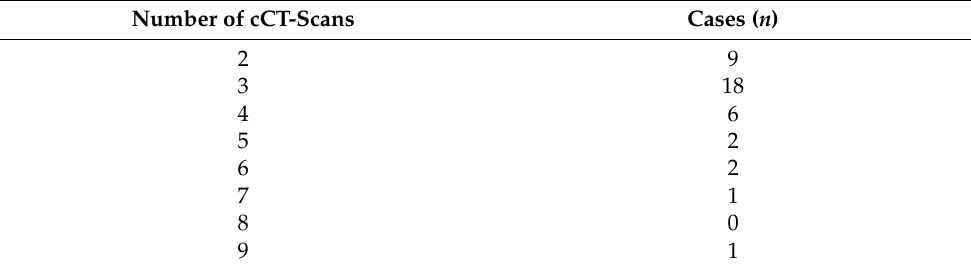
Table 4. Number of cCT-scans of patients with primary bleeding.